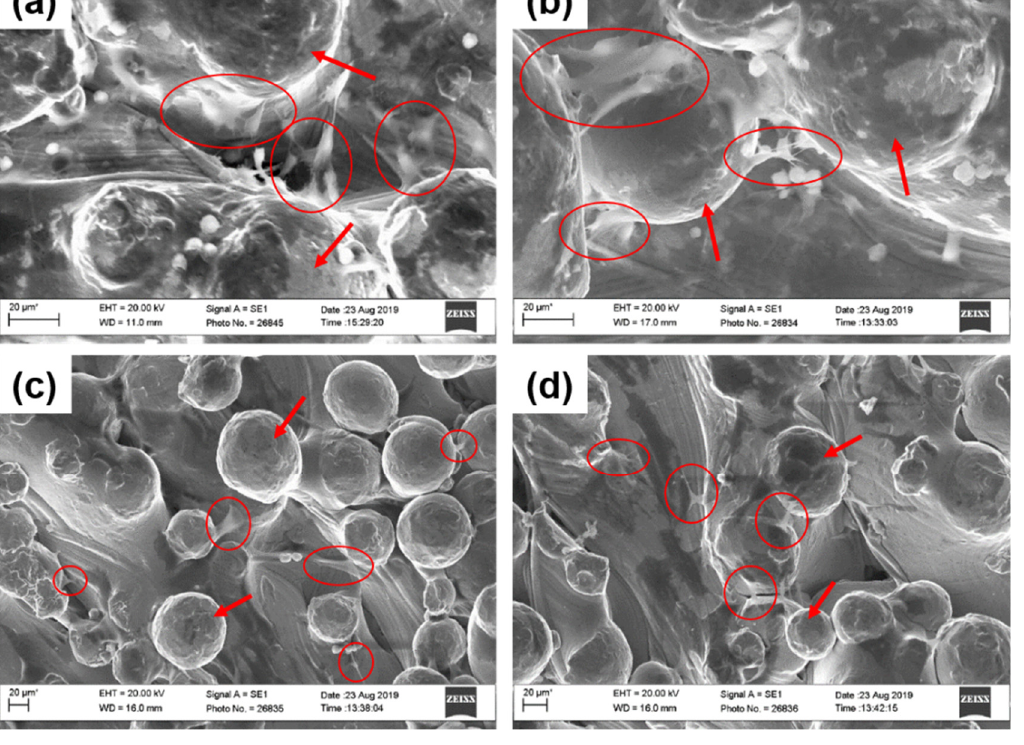
Figure 6. SEM images of ( a ) osteoblasts on Ti uncoated and on ( b ) Ti_Col_high coating and ( c ) fibroblasts on uncoated Ti and on ( d ) Ti_Col_high coating after 3 days of culture. Circles indicate cells and arrows indicate particles of Ti6Al4V powder (scale bars: 20 μ m). Ti: titanium alloy Ti6Al4V; Ti_Col: collagen-coated Ti; Ti_Col_low: collagen and low PG concentration-coated Ti; Ti_Col_high: collagen and high PG concentration-coated Ti.